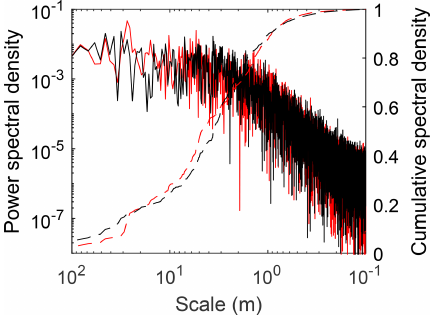
Figure 2. Site-level absolute (solid lines) and cumulative (dashed lines) power spectral density of height along a 300m transect for the Red Earth Creek, AB (red), and Nobel, ON (black),